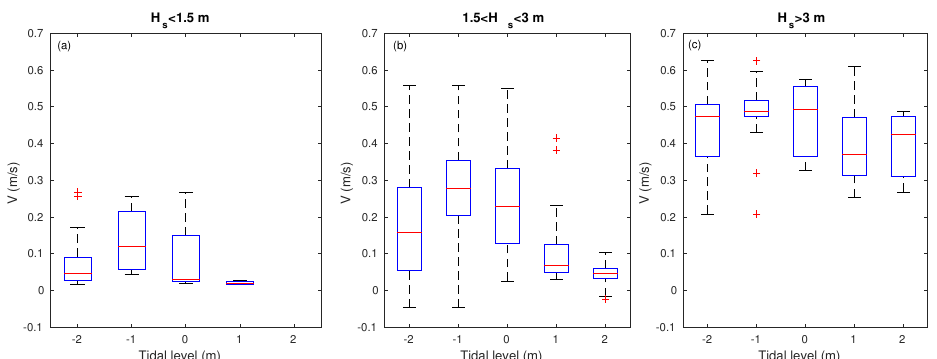
Figure 5. Boxplot for cross-shore velocity V with respect to the tidal elevation for deflection regime ( P l > 0). Data are processed into successive 1-m tidal elevation box, from − 2.5 to 2.5 m, for three ranges of wave conditions: ( a ) H s < 1.5 m, ( b ) 1.5 < H s < 3 m and ( c ) H s > 3 m. In each boxplot, the horizontal red line is the median and the y-limits of the box are the 25th and 75th percentiles while the red crosses are